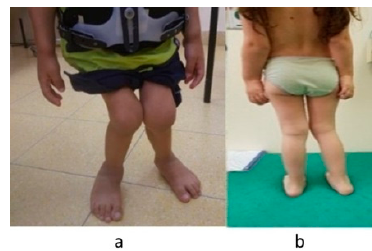
Figure 3. Lower limbs deformities: ( a ) patient 1 (72 months); ( b ) patient 2 (48 months).